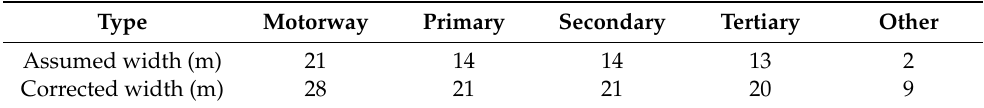
Table 3. Assumed street width depending on street